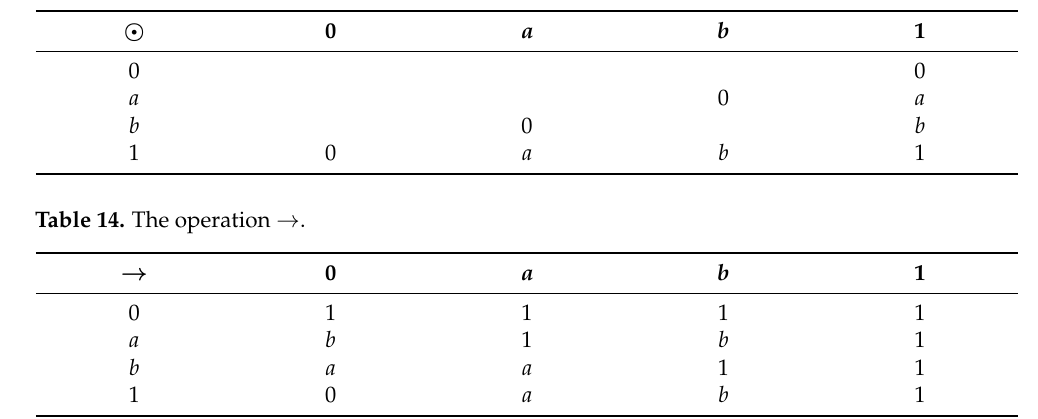
Table 13. The operation (cid:12) .